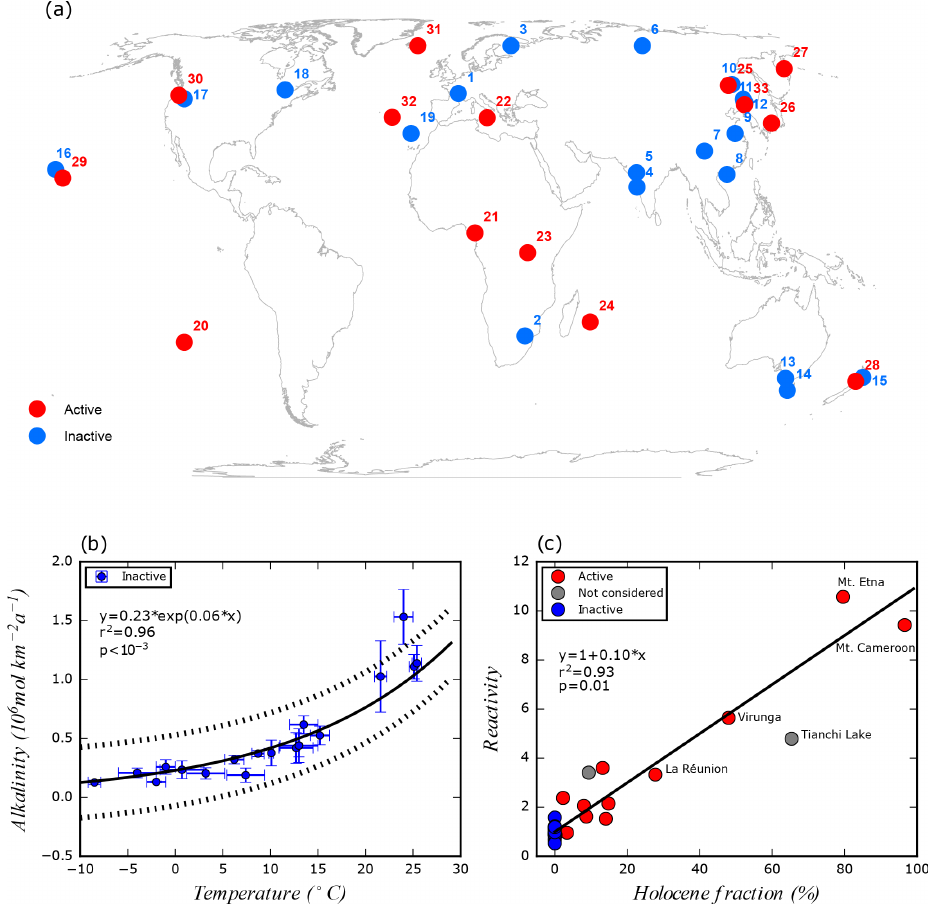
Figure 1. (a) The global map shows the locations of the active volcanic fields (in red) and the inactive volcanic fields (in blue) used in this study (1. Massif Central, 2. South Africa, 3. Karelia, 4. coastal Deccan, 5. interior Deccan, 6. Siberian Traps, 7. Mt. Emei, 8. Leiqiong, 9. Nan- jing, 10. Xiaoxinganling, 11. Tumen River, 12. Mudan River, 13. southeast Australia, 14. Tasmania, 15. North Island, NZ, 16. Kauai, Hawaii, 17. Columbia Plateau, 18. northeast North America, 19. Madeira Island, 20. Easter Island, 21. Mt. Cameroon, 22. Mt. Etna, 23. Virunga, 24. La Réunion, 25. Wudalianchi Lake, 26. Japan, 27. Kamchatka, 28. Taranaki, 29. Big Island, Hawaii, 30. High Cascades, 31. Iceland, 32. São Miguel Island, 33. Tianchi Lake). (b) The exponential relationship between area specific alkalinity flux rates and the land surface temperature for IVFs. The dashed lines represent the range of the mean residual standard deviation of the function (see the Supplement). Note that r 2 and the p value were derived by a linear regression of calculated alkalinity flux rates vs. estimated alkalinity flux rates using the new scaling law. (c) The relationship between the Holocene area fraction of the used watersheds from the volcanic fields and the weathering reactivity R . Note that Tianchi Lake and São Miguel are excluded from the calculation of the regression line because the applied catchments were not dominated by basalt but by trachytic volcanic rock types. Both data points still seem to follow the identified regression trend line for AVFs. r 2 and the p value were calculated by a linear regression of the Holocene fraction vs. reactivity for all